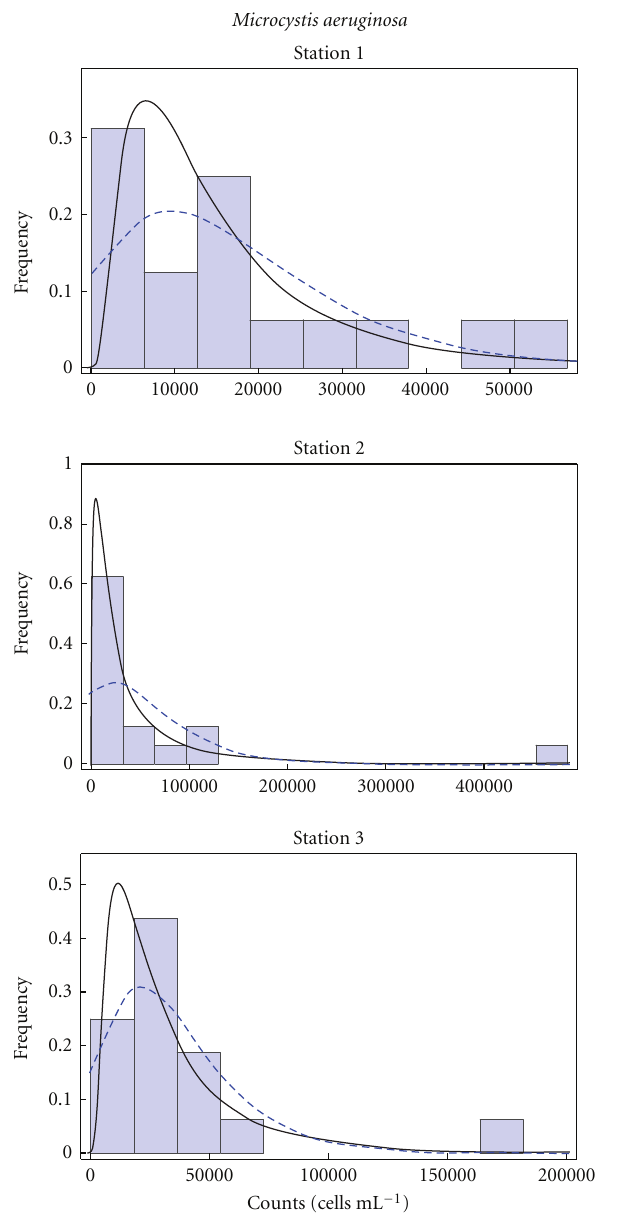
Figure 8: Histograms of toxin concentration in the water at the three sampling sites described by the Log-normal (solid line) and extreme value (dashed line) distribution